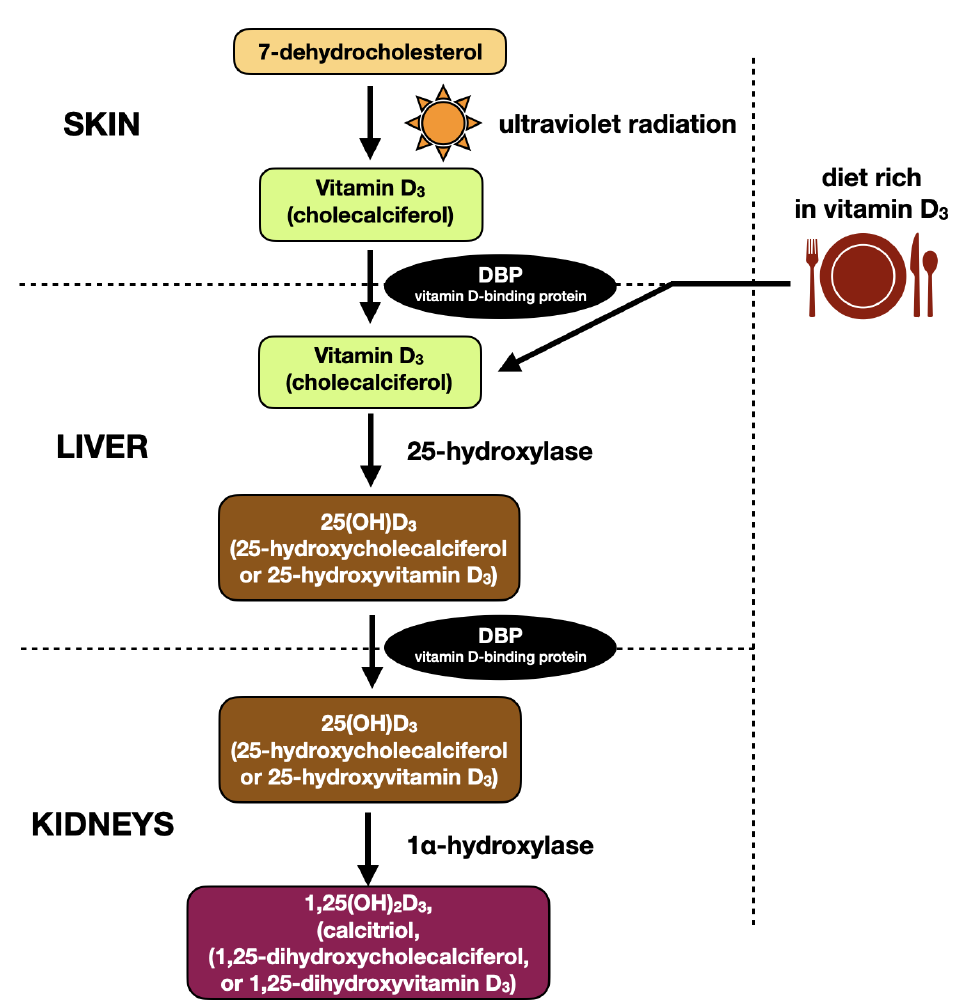
Figure 2. Metabolic pathway of vitamin D 3 on the basis of the literature [27,31].